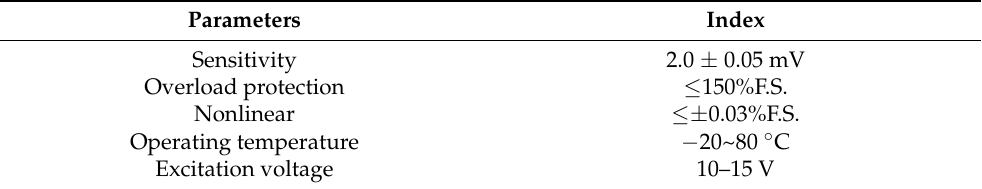
Table 2. Parameters of cantilever beam sensor.